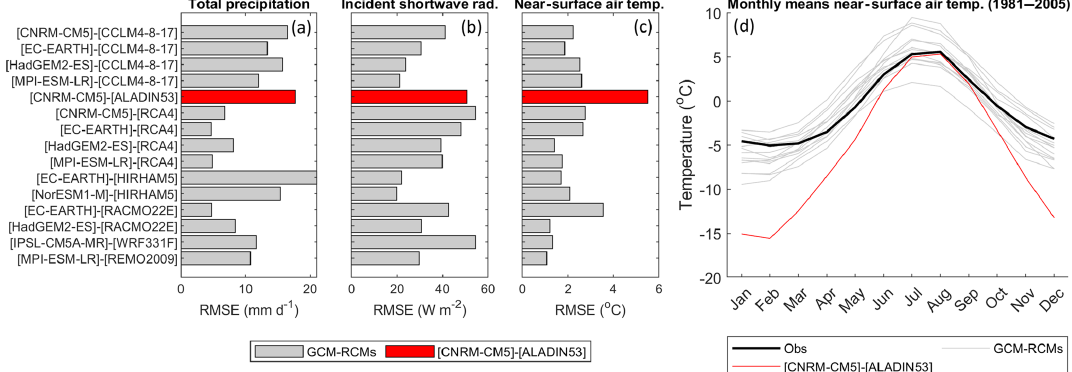
Figure A2. Root mean squared error scores calculated by comparing monthly empirical distribution functions constructed from catchment- average daily observed and simulated (GCM–RCM) total precipitation (a) , incident solar radiation (b) , and near-surface air tempera- ture (c) data over the recent past (1981–2005). Also shown are the observed and simulated monthly mean near-surface air temperatures for the recent past (d)